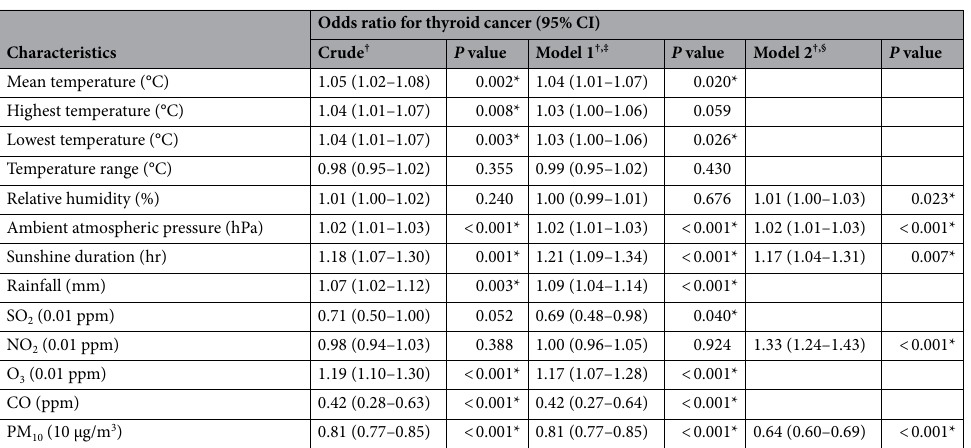
Table 2. Crude and adjusted odds ratios (95% confidence interval, CI) of meteorological conditions and air pollution parameters (mean of 3 years [1095 days] before index date) for thyroid cancer. CCI